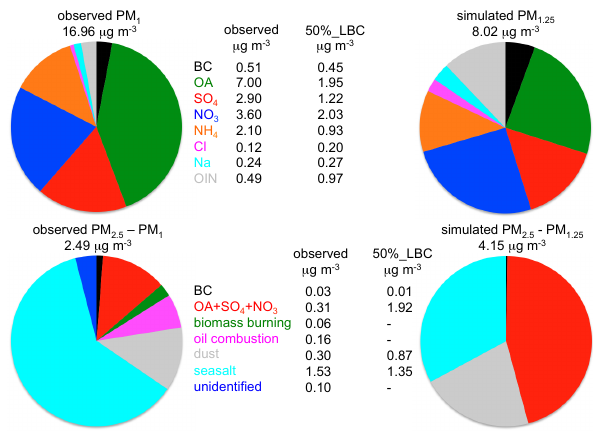
Figure 23. Average aerosol composition observed (left) and simu- lated (right) at the Pasadena site. Observations adapted from Hayes et al. (2013) where PM 1 observations obtained from AMS, ele- mental carbon/organic carbon EC/OC Sunset Analyzer, and X-ray fluorescence analysis and PM 2 . 5 –PM 1 observations obtained from PALMS particle